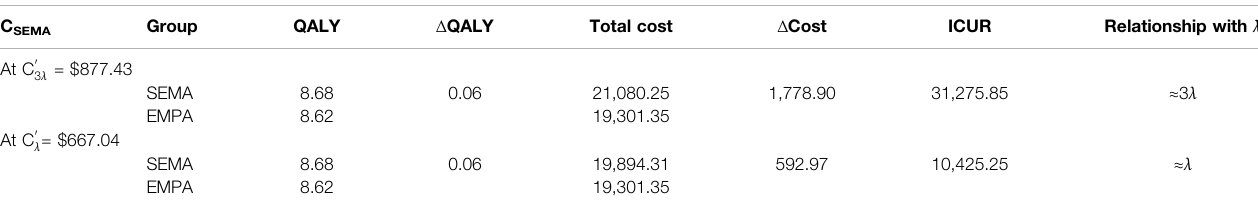
Frontiers in Pharmacology |